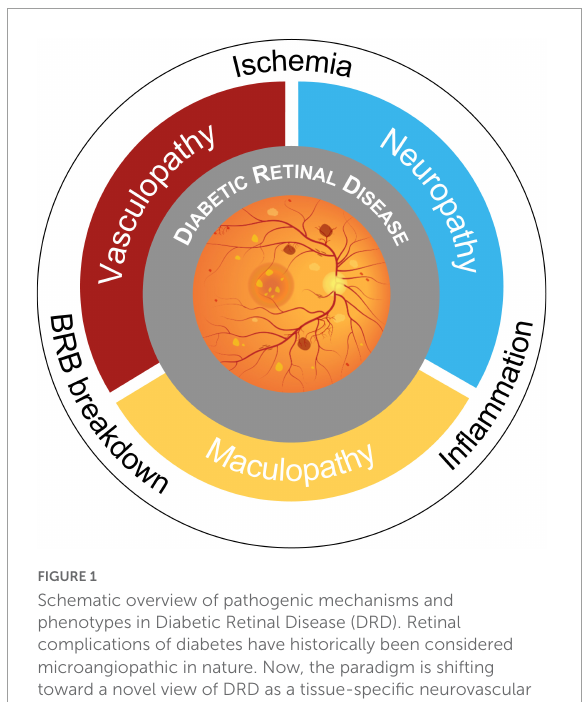
FIGURE1 Schematic overview of pathogenic mechanisms and phenotypes in Diabetic Retinal Disease (DRD). Retinal complications of diabetes have historically been considered microangiopathic in nature. Now, the paradigm is shifting toward a novel view of DRD as a tissue-specific neurovascular complication due to blood-retinal barrier (BRB) breakdown, retinal and optic nerve head ischemia, and